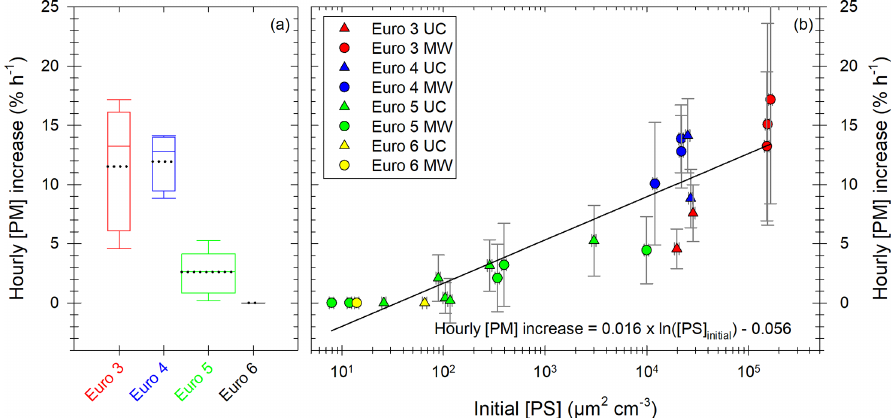
Figure 8. Particle mass hourly increase in percentage of initial [PM] per hour. Results in (a) are given for all the diesel vehicles sorted by Euro norm. The boxes represent the 25th and 75th percentile. The solid line in the center represents the median; the dashed line represents the mean. The whiskers are the 10th and 90th percentiles. The width of the boxes is proportional to the data set of the box. Results in (b) are given as a function of initial particle surface [PS] for all Euro norms (Euro 3 in red; Euro 4 in blue; Euro 5 in green; Euro 6 in yellow or black) and under both UC (triangles) and MW (circles) conditions. The x axis is presented with a logarithmic scale. A logarithmic fit of the data is performed (black line) with equation written in panel (b) . Error bars in panel (b) represent 1 standard